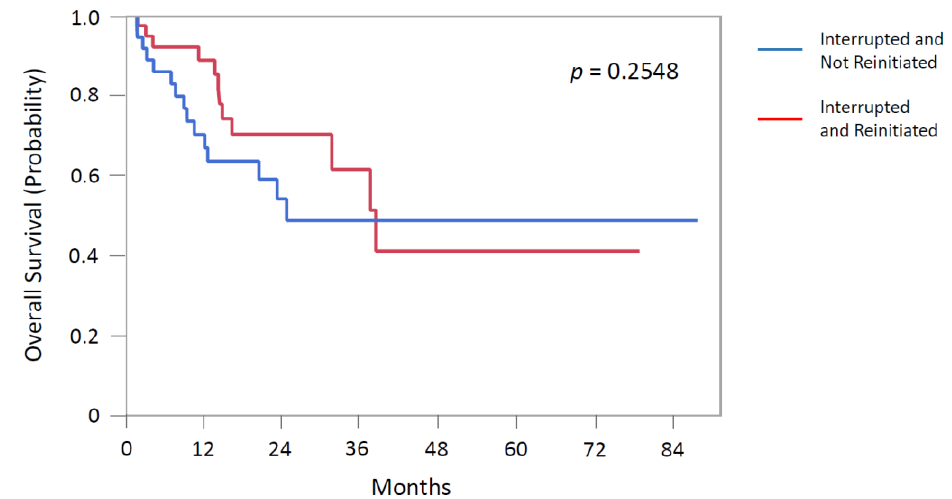
Figure 1. Kaplan-Meier Survival Analysis of Study Patients with ICI irAEs Having ICI Interrupted and Not Reinitiated (i.e., Discontinued) (blue) versus Interrupted and Reinitiated (red).